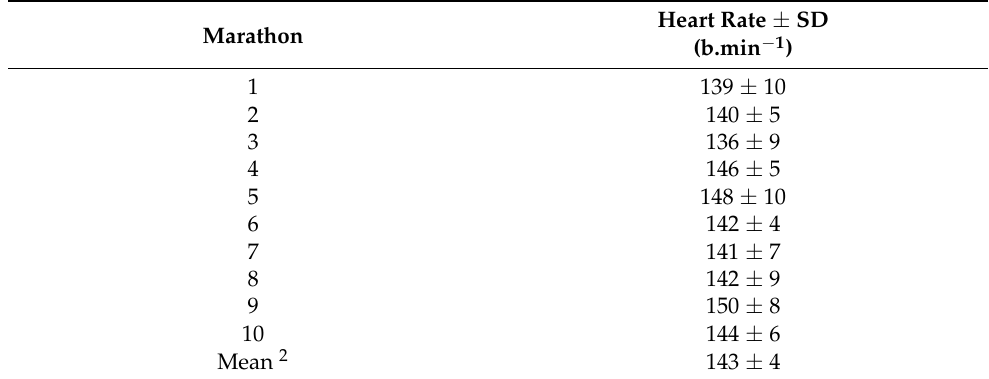
Table 2. Heart rate for all 10 marathons.